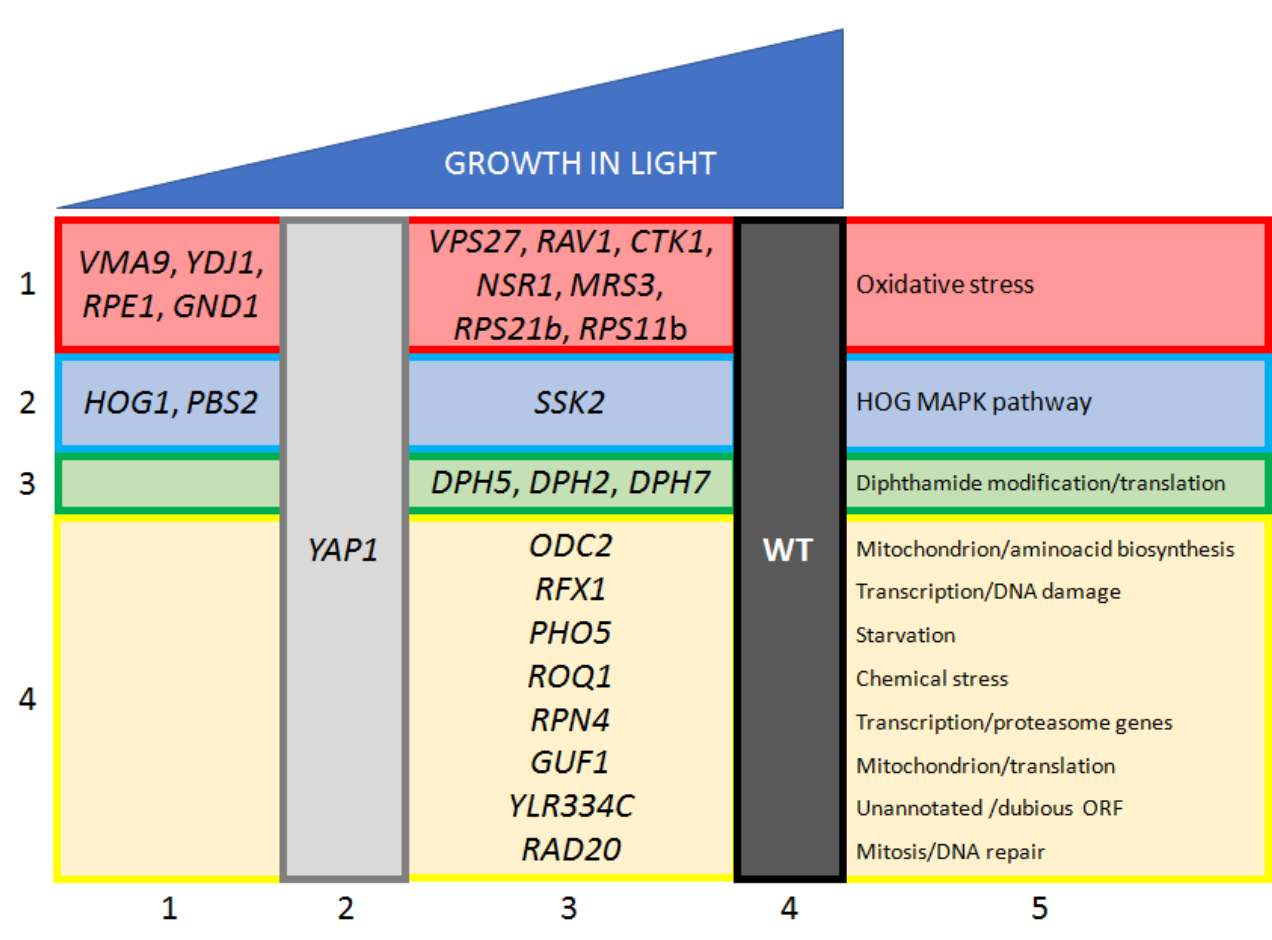
Figure 2. Light-sensitive mutants in S. cerevisiae . The graphical table reports yeast genes whose deletion proved to generate reduced growth under white light exposure (modified from [34]). Column 1 contains genes corresponding to a growth defect more severe than the defective reference strain with deleted YAP1 (Column 2). Column 3 contains genes with a defect less severe than YAP1 but growing significantly slower than the wild type (Column 4). Lines 1–4 group genes by function (described in Column 5): oxidative stress (line 1, red); HOG–MAPK pathway (line 2, blue); diphthamide modification (histidine modification to diphthamide in the elongation factor eEF2; line 3, green); miscellanea (line 4, yellow).